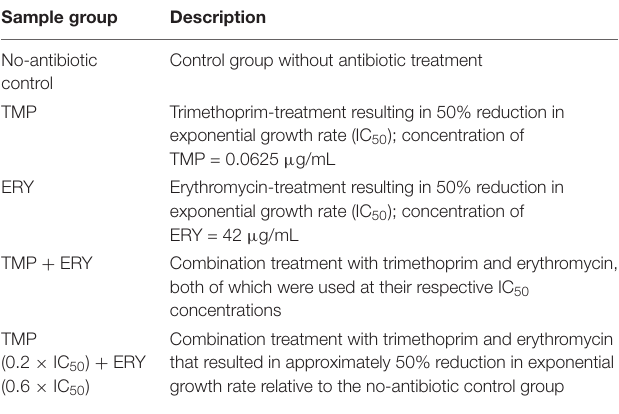
TABLE 1 | Sample groups TMP, ERY, TMP + ERY and the no-antibiotic treatment control for RNA-Seq transcriptomic profiling using the E. coli MG1655 strain. Sample